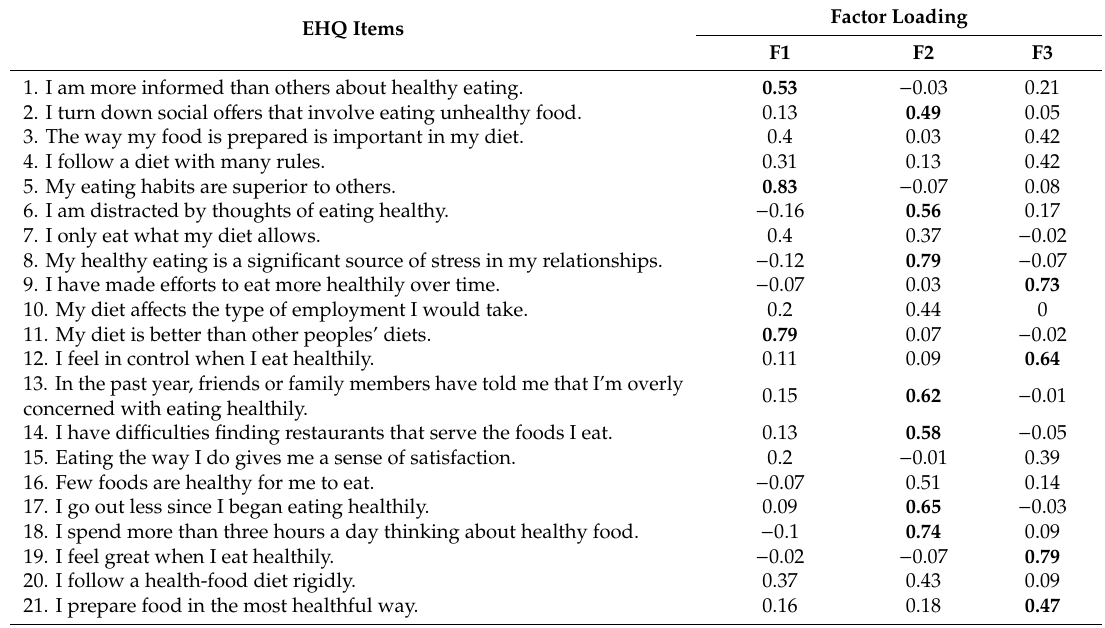
Table 1. Exploratory factor analysis (EFA) results of the Polish version of the EHQ. EHQ Items